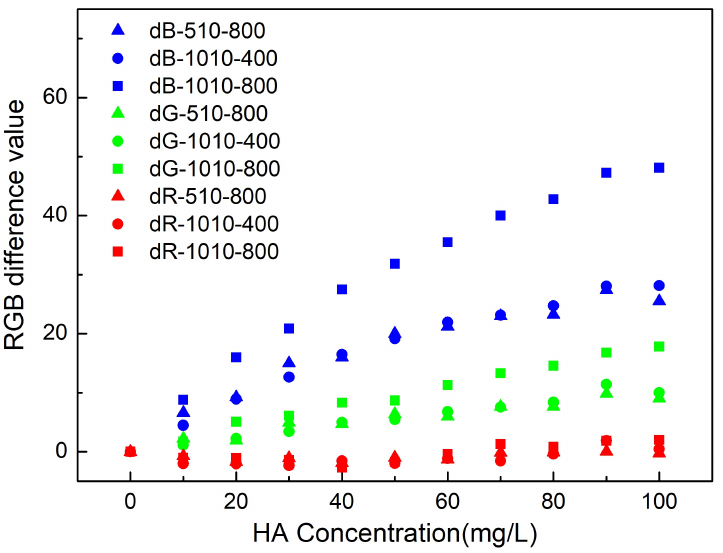
Figure 3. The RGB difference value calculated from the image at different light illuminations (i.e., 510 and 1010 Lux) and different camera ISO (i.e., 400 and 800) of dissolved humic acid at gradually increasing concentrations (ultra-pure water sample as the blank). R denotes red channel, G denotes green channel, B denotes blue channel. After the color channel, the light illumination comes after, and the last is the camera ISO setting. For instance, dR-510-800 denotes the difference of red channel derived from the image taken at 510 Lux illumination with camera setting at ISO800. (The legends in subsequent figures follow the same